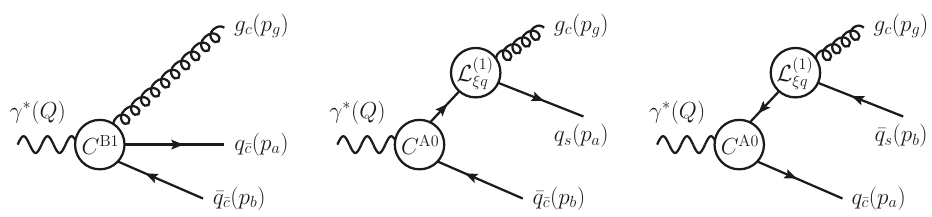
Figure 2 . SCET representation of the “off-diagonal” gluon-thrust amplitude in the two-jet region. The diagrams show the NLP structure of the process with all LP interactions